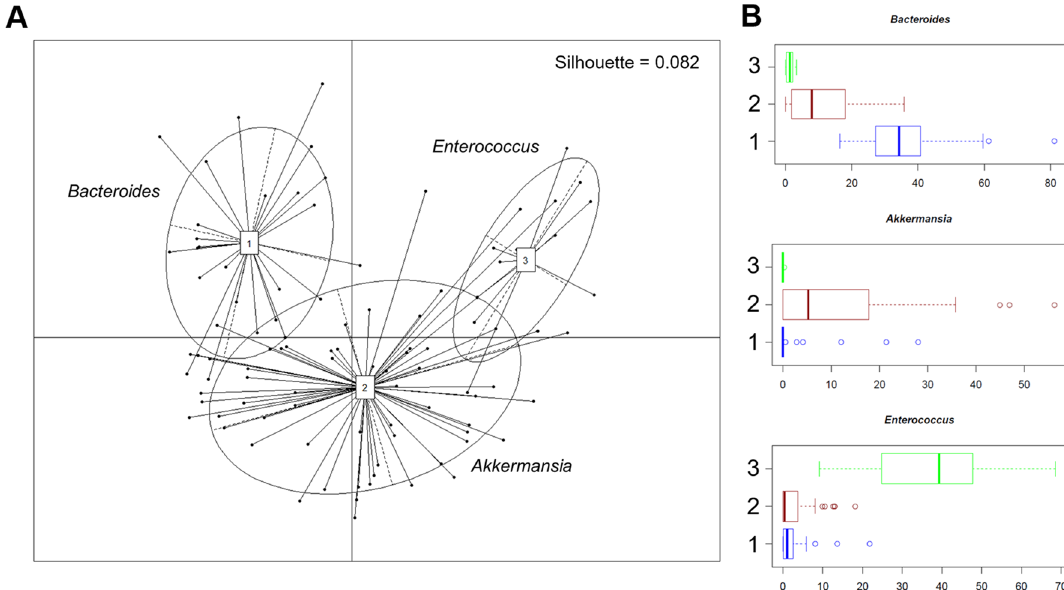
Figure 3. Enterotype-like groups in SCI patients. ( A ) Principal Coordinates Analysis of enterotype clusters in SCI patients. Three enterotypes were identified by using the Jensen-Shannon divergence distance metric. The ellipse covers 67% of the samples belonging to a cluster. The silhouette coefficient is shown at the top right. ( B ) Box plots showing the distribution of the relative abundance values of discriminant genera among the three enterotype-like groups. p < 0.001, Kruskal–Wallis test.